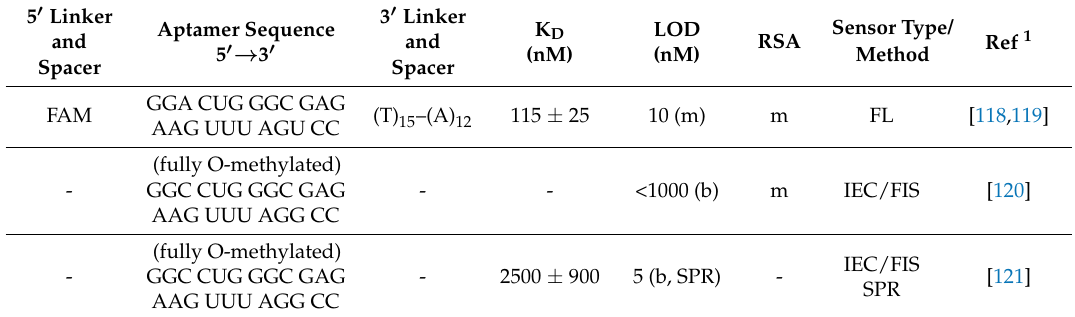
Table 5. Aptamer sequence, dissociation constant (K D ), limit of detection (LOD), real sample analysis (RSA), and realized sensor type and measuring method for neomycin B, mentioned in the corresponding references (Ref). b = buffer, FAM = fluorescein amidite, FIS = Faradaic impedance spectroscopy, FL = fluorometric, IEC = impedimetric electrochemical, m = milk, and SPR = surface plasmon resonance